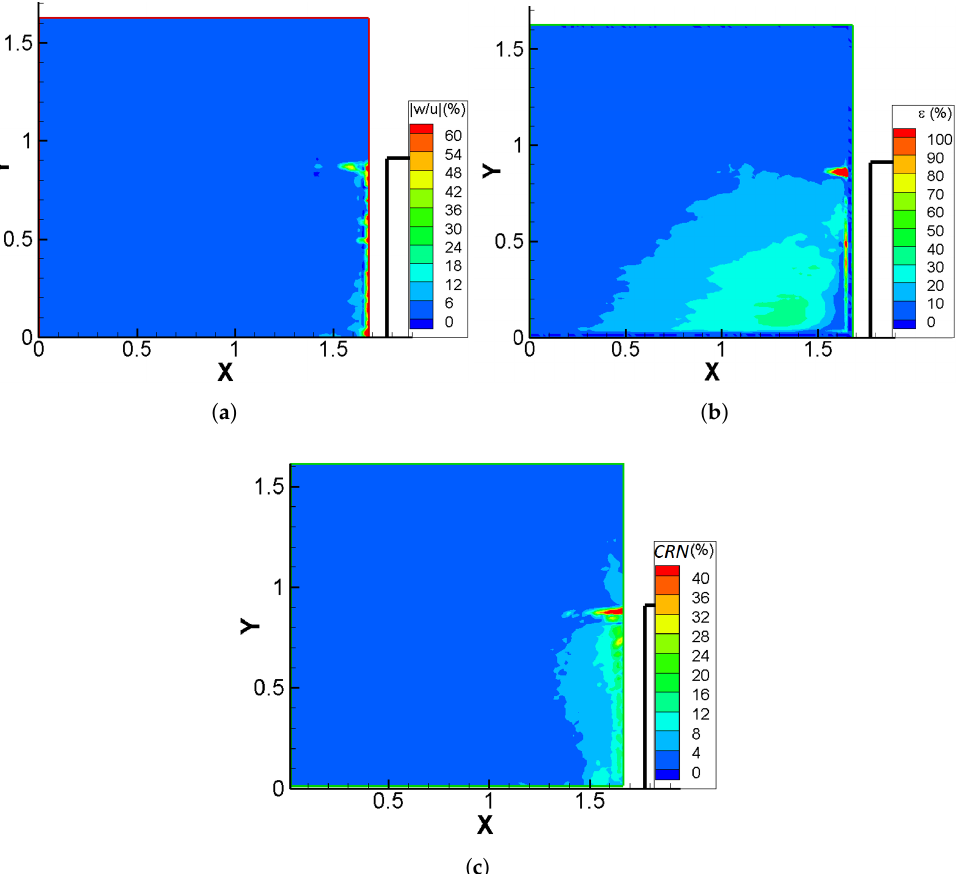
Figure 6. Contours of: ( a ) the absolute value of the fraction of the third velocity component w over the u velocity component (acquired through stereo-PIV), | w / u | %, on plane A. ( b ) The difference between the CFD estimate of the total velocity and that of the PIV method, (cid:101) ( % ) , on plane A. ( c ) The non-dimensional continuity residual, CRN ( % ) , for the PIV results on plane A. The solid boundary of the cube is denoted by the thick black line, while X and Y are non-dimensional coordinates. Flow is from left to